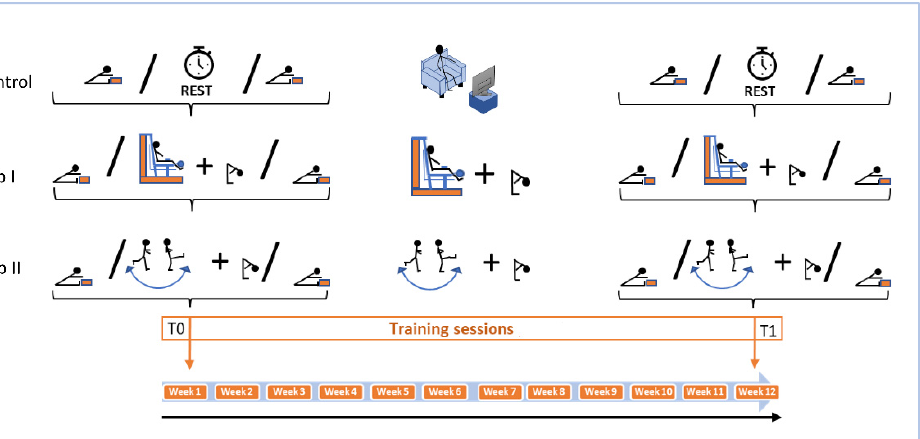
Figure 1. Timeline of exercises performed by the three groups during the follow-up interventions. Exp I: strength training combined with specific flexibility exercise; Exp II: dynamic flexibility train- ing combined with specific flexibility exercise; control: maintained a sedentary lifestyle during the training period. In T0 and T1, we assessed the effect of a single session in the three groups. The control group had only a rest period to wash out the effect of the sit-and-reach test.